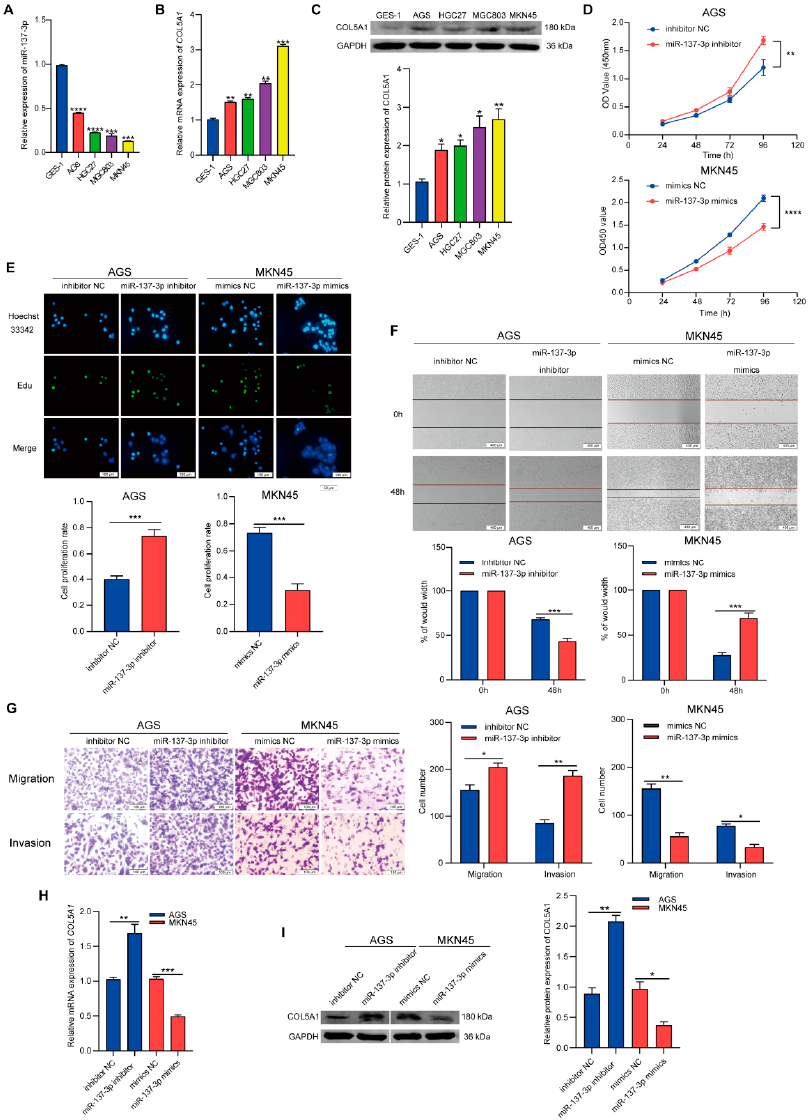
Figure 3. MiR-137-3p played a tumor-suppressive role in GC. ( A ) The expression level of miR-137- 3p in GC cells was detected by qRT-PCR. The expression level of COL5A1 in GC cells was detected by qRT-PCR ( B ) and Western blotting ( C ). CCK-8 assays ( D ) and EdU assays ( E ) were carried out to evaluate the cell proliferation ability. Wound healing assays ( F ) and Transwell assays ( G ) were conducted to evaluate the migration and invasion ability in different groups. qRT-PCR ( H ) and Western blotting ( I ) were used to detect the mRNA and protein levels of COL5A1 after transfection of miR-137-3p mimics or inhibitor. Full uncropped figures of Western blotting can be found in Supplementary File S5. Data are presented as mean ± SD of three independent experiments. * p <